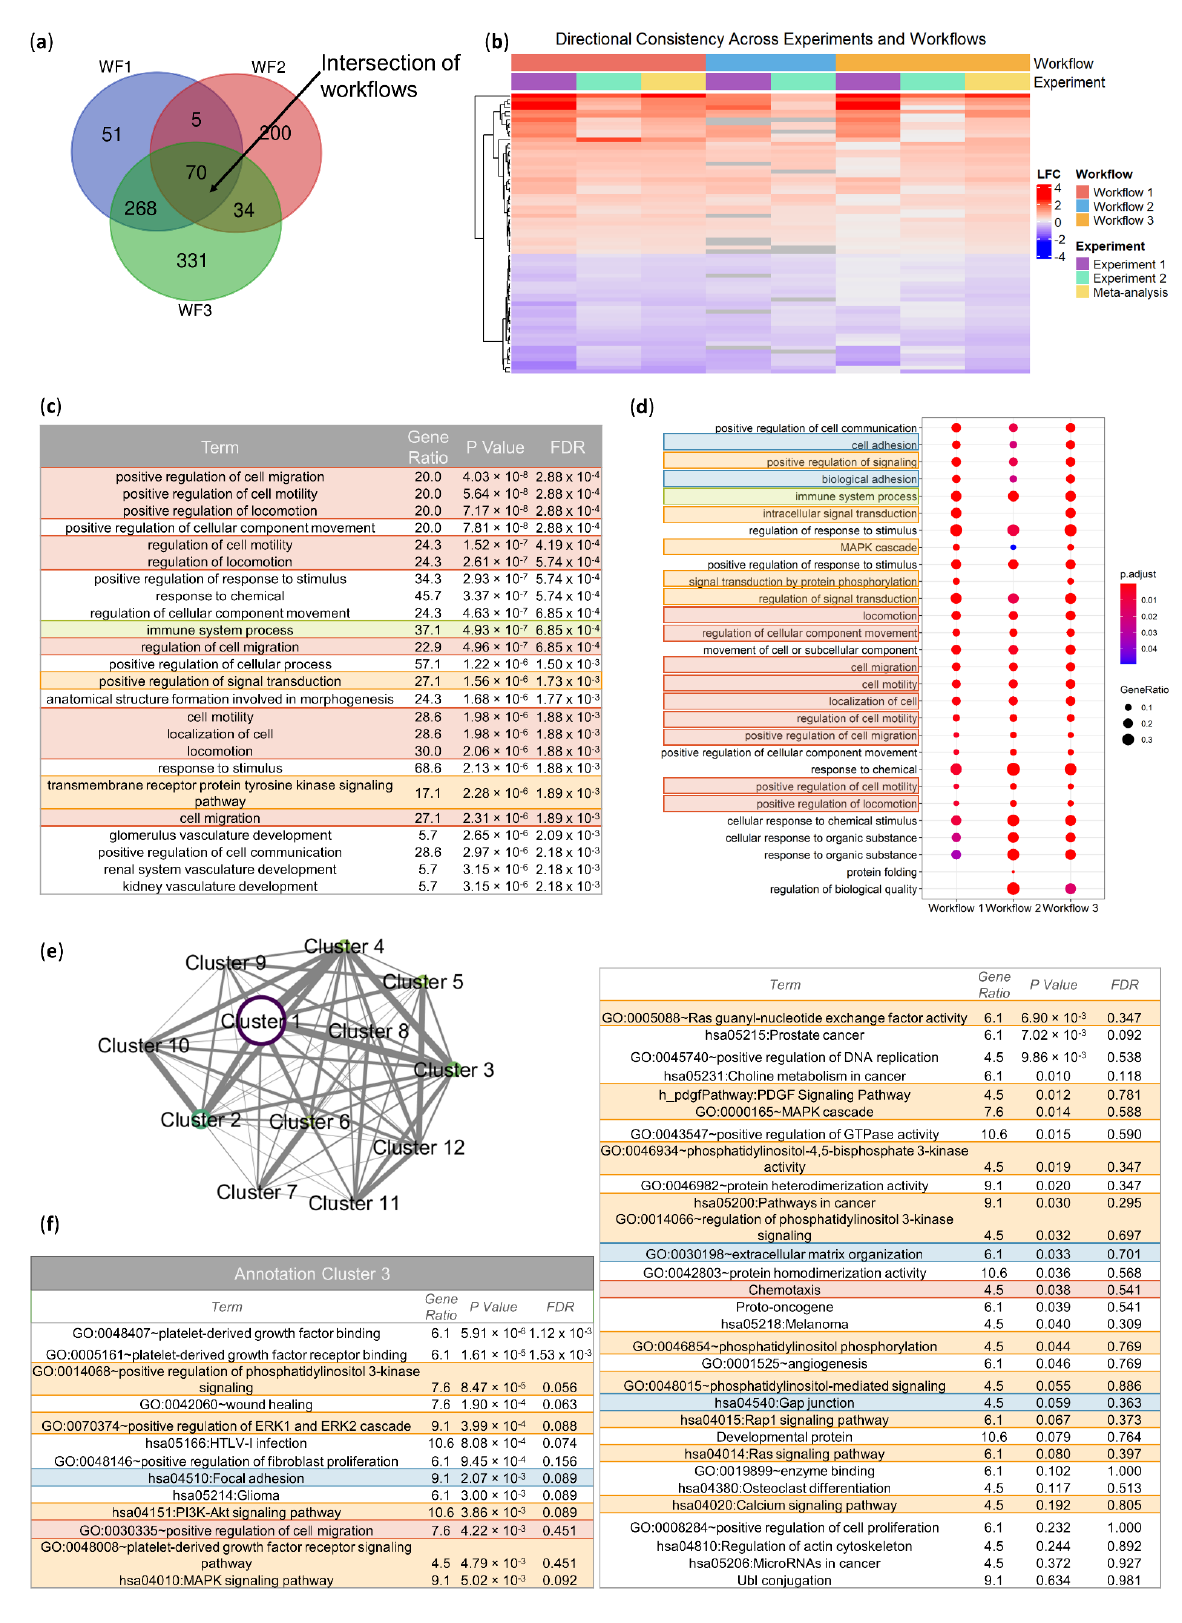
Figure 7. 4SC-202-induced differentially expressed genes are implicated in biological processes related to cell adhesion (blue), movement (red), immune processes (green), and cancer-related signaling pathways (orange). ( a ) Venn diagram of the intersection of the differentially expressed genes